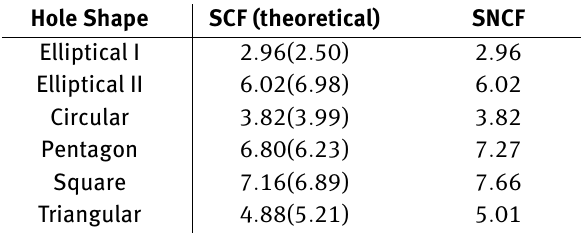
Table 5: Effect of hole shape on stress and strain